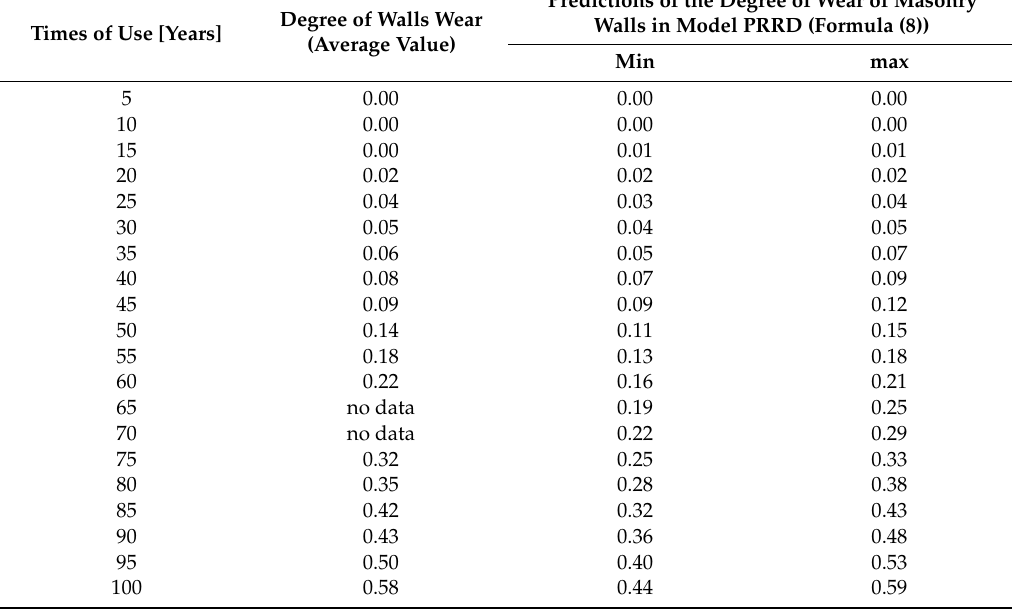
Table 2. Predictions of the degree of wear of masonry walls. Prediction of Reliability according to Raleigh Distribution (PRRD), as well as values of the degree of wall wear resulting from the periodic inspection of buildings located in Zielona G ó